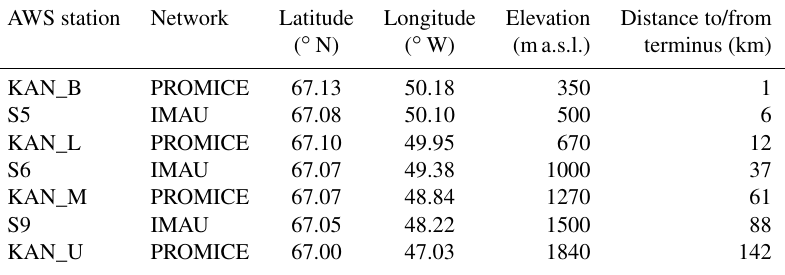
Table 1. Summary details of the PROMICE and IMAU AWS stations utilized in this study, including their approximate geographic position (in decimal degrees), elevation, and distance from the ice sheet terminus moving west to east. KAN_B is located on the tundra, roughly 1km to the west of the terminus. Distances are rounded to the nearest km as on-ice AWS sites are known to move ∼ 50–150myr − 1 (van de Wal et al.,